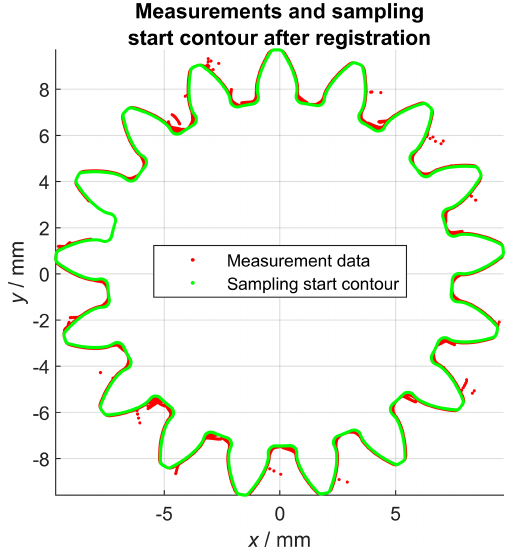
Figure 7. Projection of the calculated nominal geometry into the x – y plane. Measurement deviations perpendicular to the probing vector ( z component is zero) are not recorded.